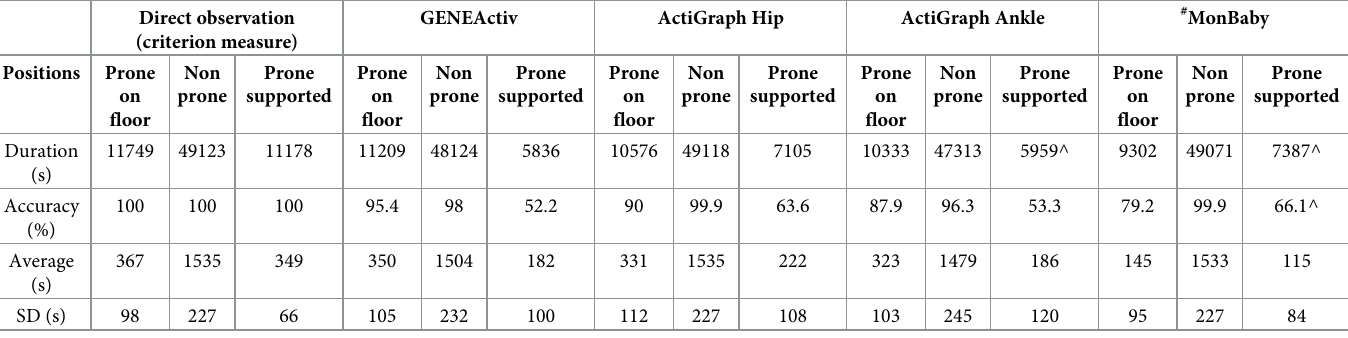
Table 2. Seconds recorded by the criterion measure and the four devices for the different categories of positions. Direct observation (criterion measure)